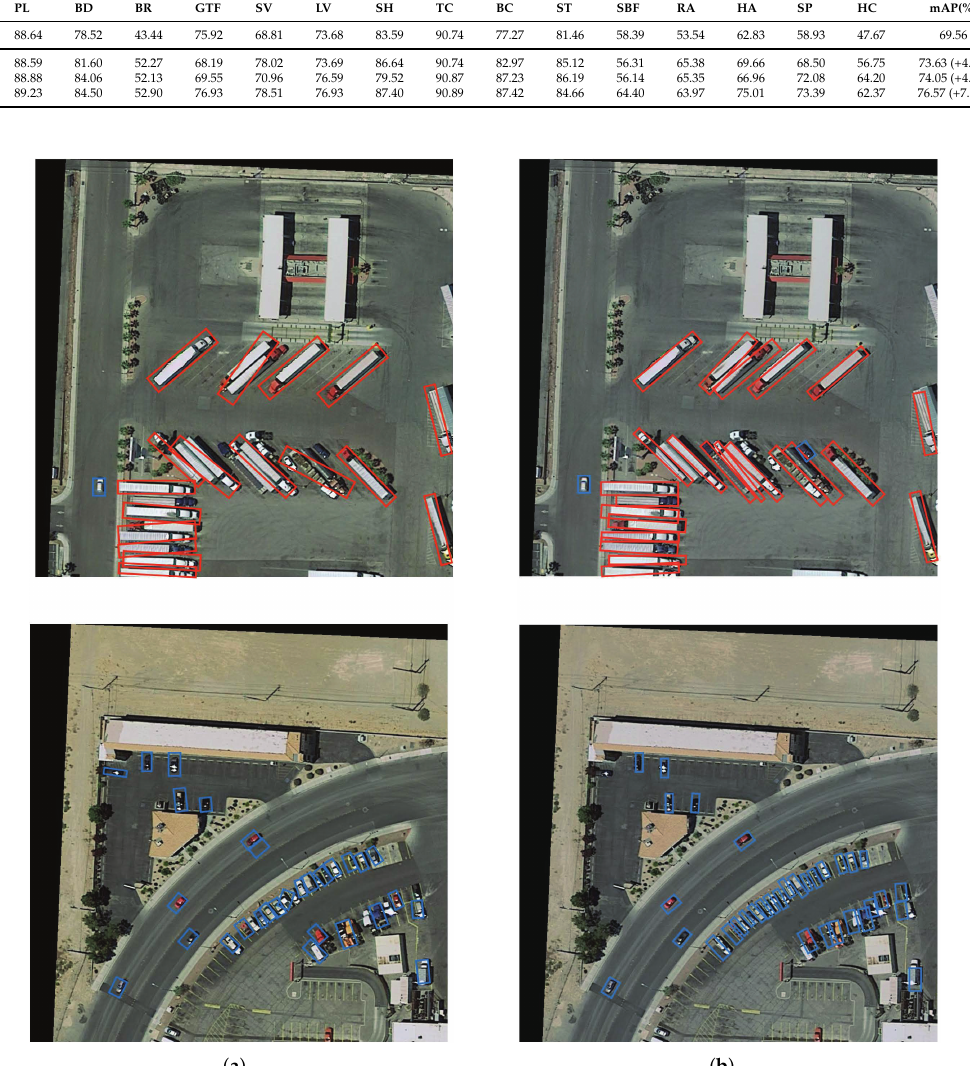
Figure 10. Depictions of the detection results on the DOTA dataset test set. ( a ) Baseline [20]. ( b ) Pro- posed